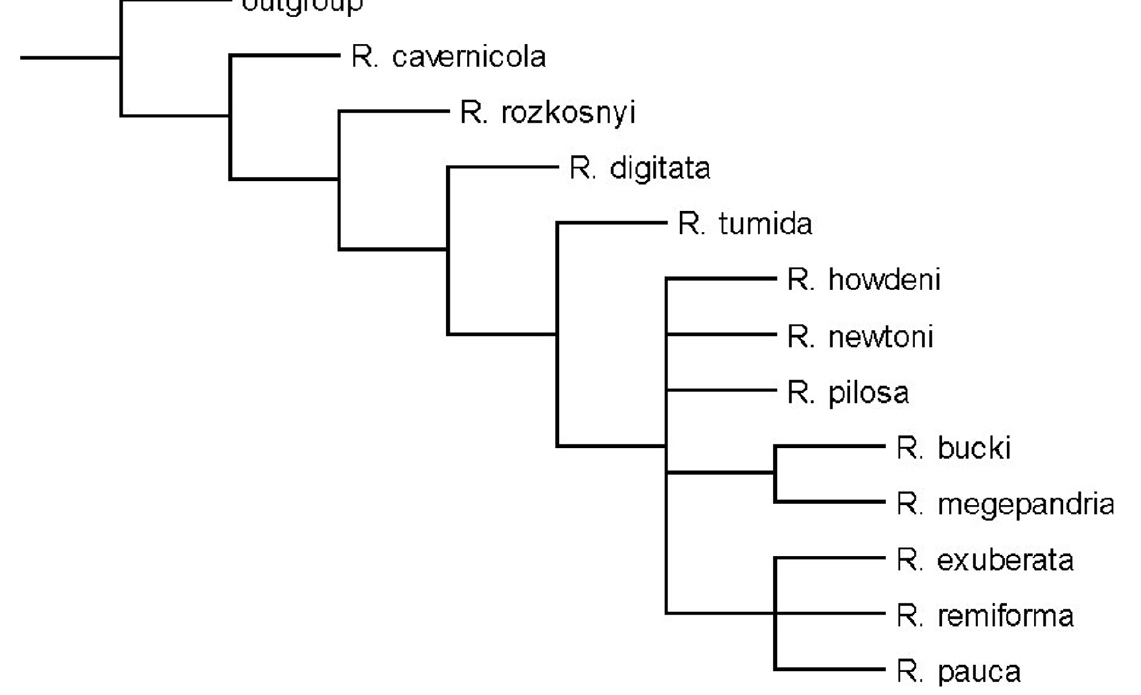
Fig. 5 . Strict Consensus Tree for the 27 recovered trees obtained from Traditional